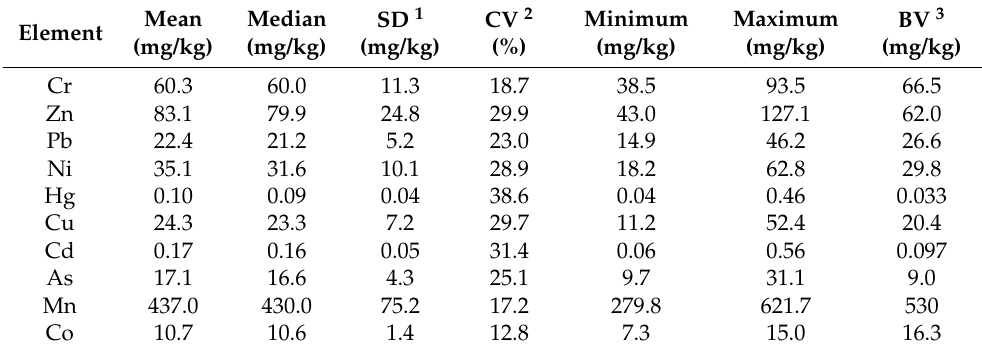
Table 2. Statistics characteristics of HM concentrations in the surface soils (n = 217).